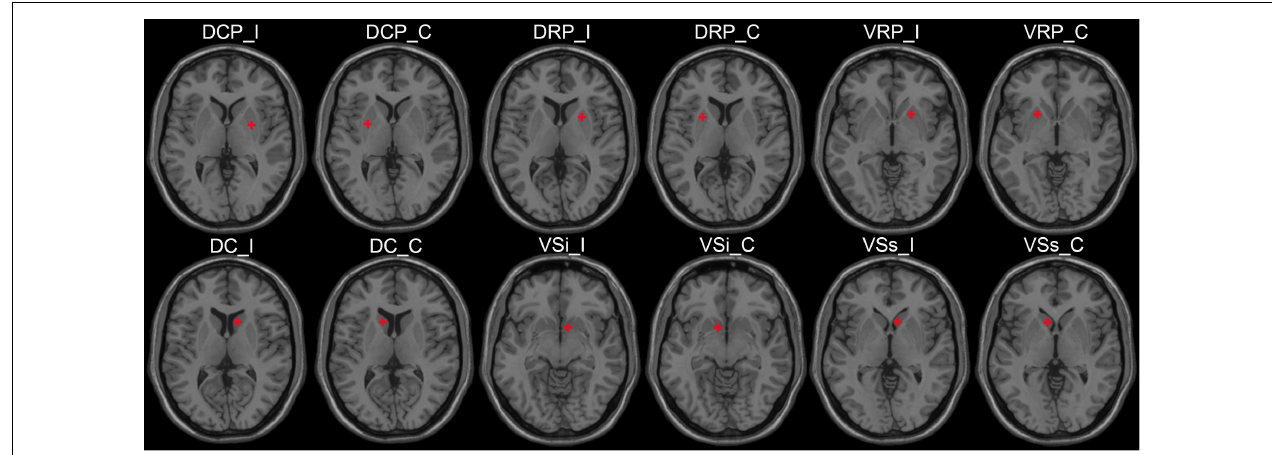
FIGURE 1 | The ROI schematic diagrams of striatal subregions. ROI, region of interest; I, ipsilateral; C, contralateral; DCP, dorsal caudal putamen; DRP, dorsal rostral putamen; VRP, ventral rostral putamen; DC, dorsal caudate; VSi, inferior ventral striatum; VSs, superior ventral striatum.